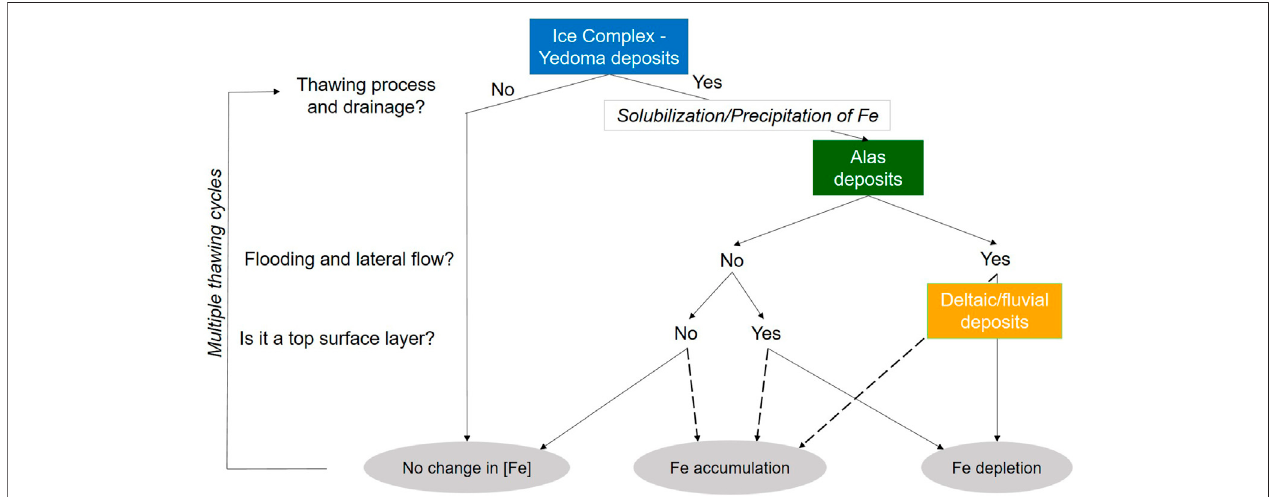
FIGURE 8 | Schematic representation of the iron dynamic within Yedoma domain deposits and the resulting impact for Fe concentration ([Fe]) in Yedoma Ice Complex (blue), Alas (green), and deltaic/ fl uvial deposits (orange). The “ Yes ” and “ No ” correspond to the answer of the question on the left side of the scheme. Dashed lines suggest the potential in fl uence of peat to create favorable oxic